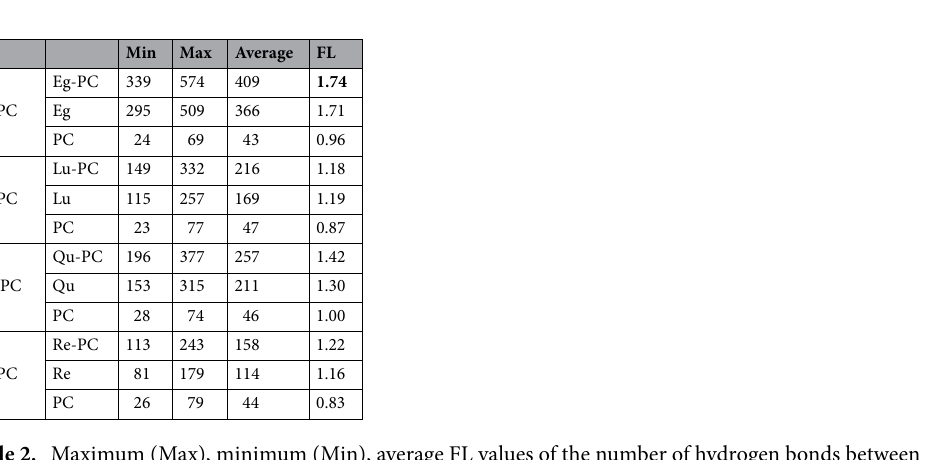
Table 2. Maximum (Max), minimum (Min), average FL values of the number of hydrogen bonds between water and different component systems. Significant values are in